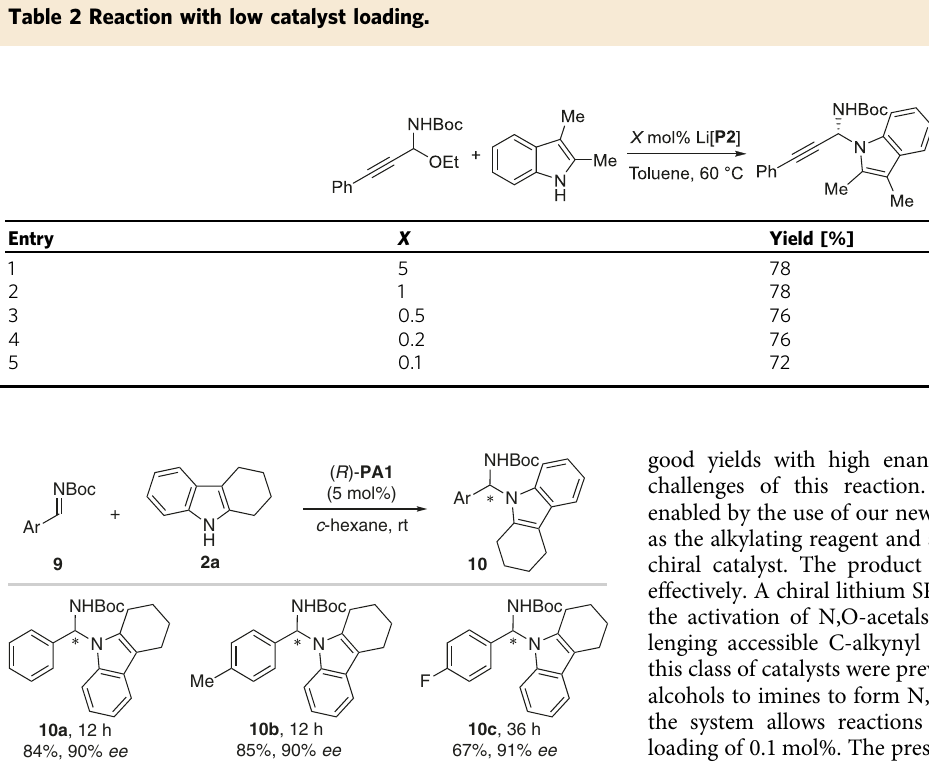
Table 2 Reaction with low catalyst loading.